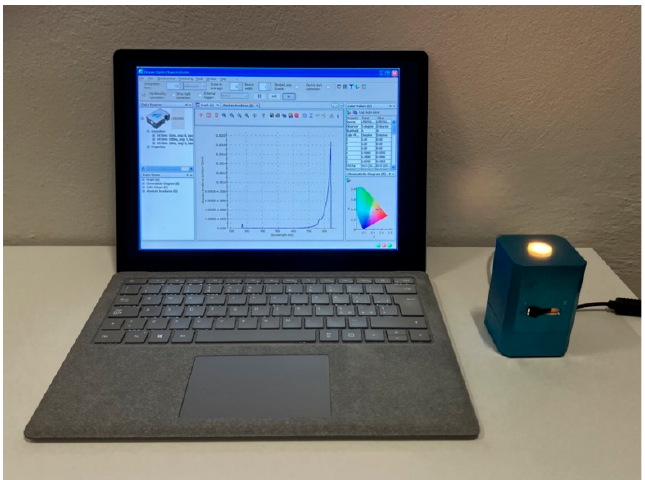
Figure 2. Representation of the spectrophotometer used for the detection of the color of the materials tested in the different laboratory conditions. CIELAB data were collected.